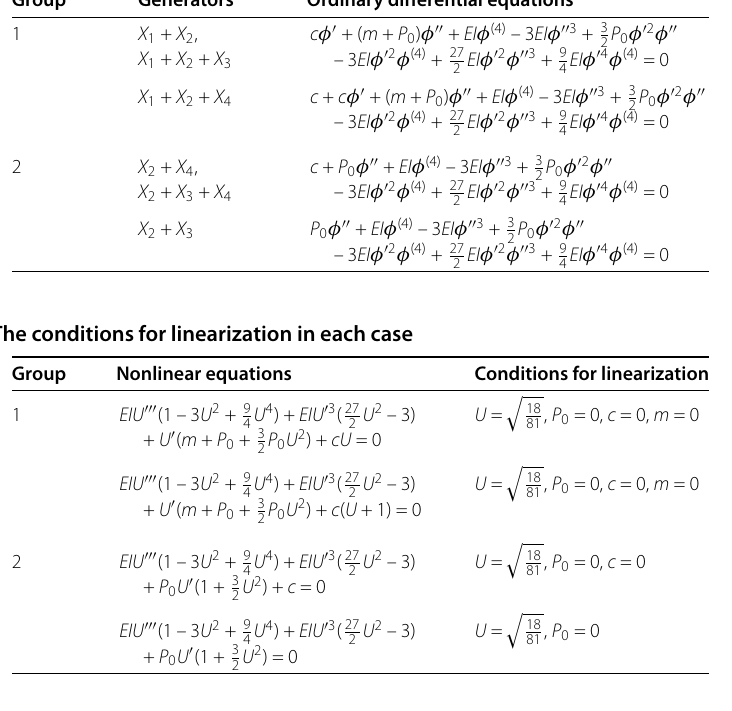
Table 1 Two groups of nonlinear ordinary differential equations Group Generators Ordinary differential equations